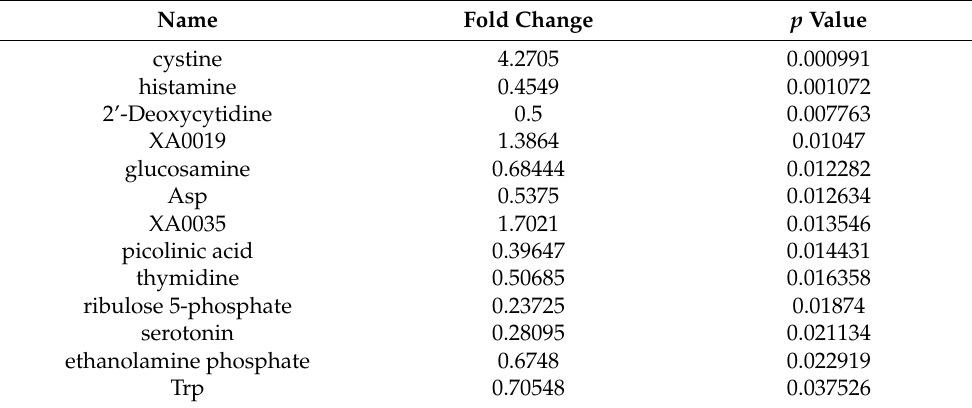
Table 1. List of TBI-induced metabolite dysregulation.